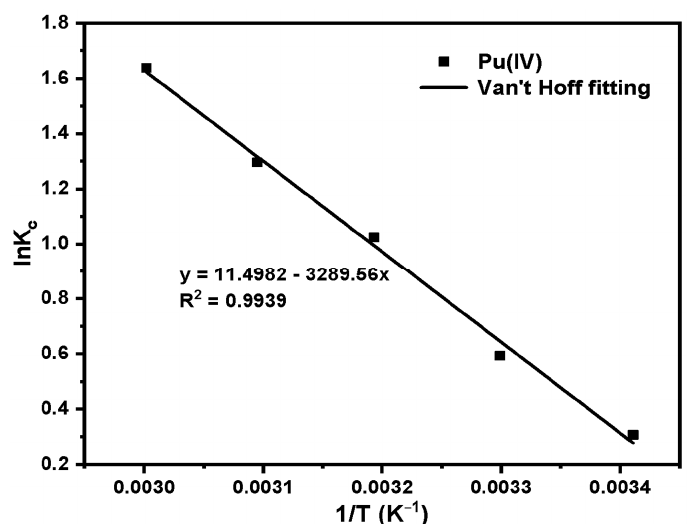
Figure 19. Fitting results of K c and 1/T of Pu(IV).